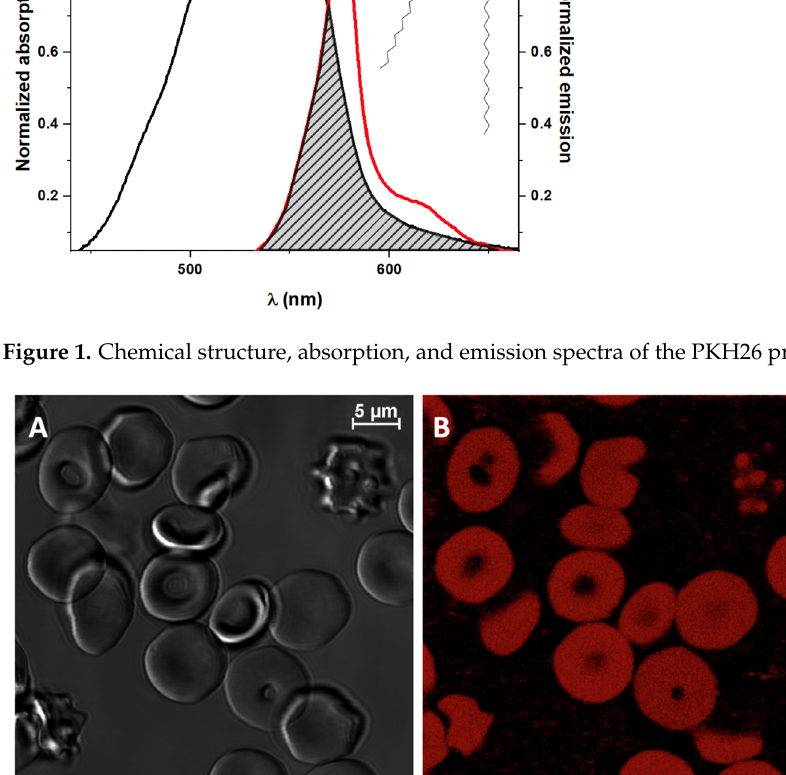
Figure 1. Chemical structure, absorption, and emission spectra of the PKH26 probe.